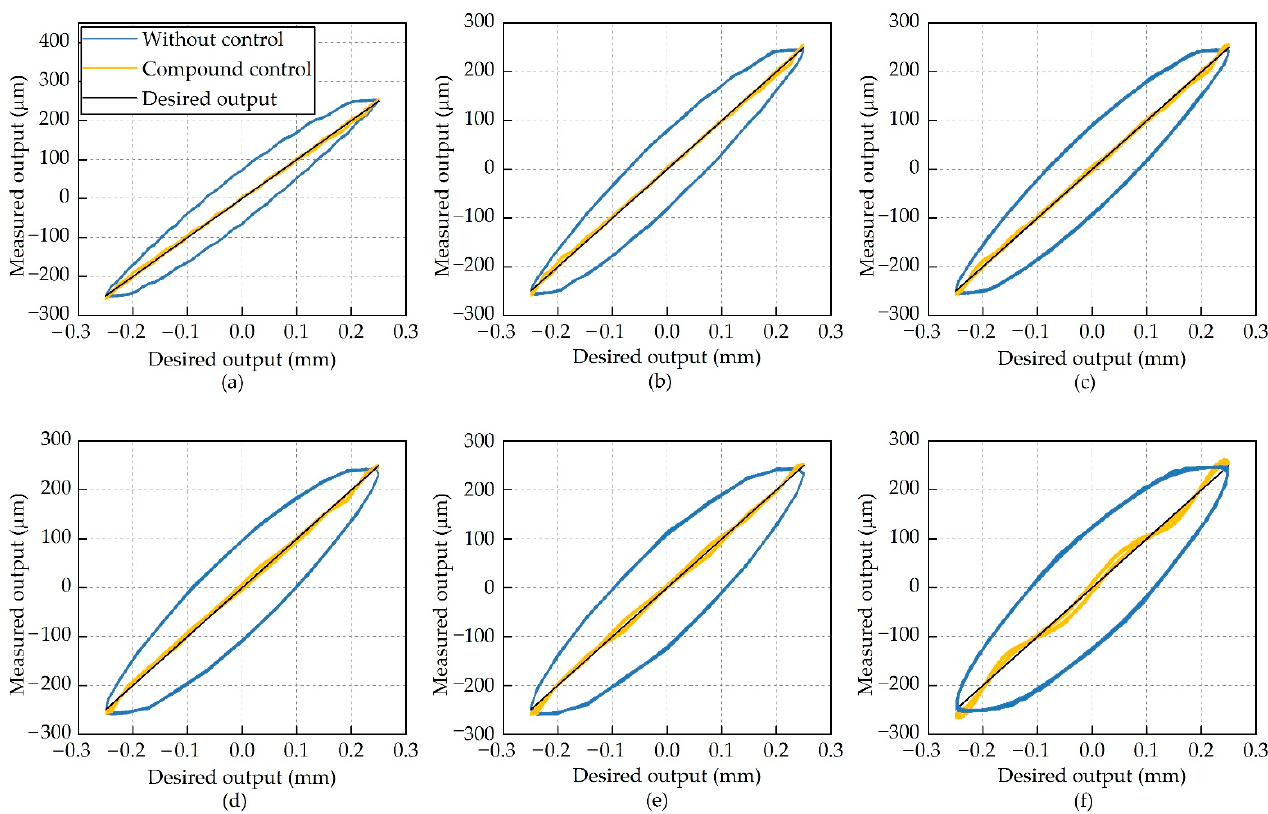
Figure 11. Actuator output strokes at different frequencies. ( a ) 10 Hz; ( b ) 20 Hz; ( c ) 30 Hz; ( d ) 40 Hz; ( e ) 50 Hz; and ( f ) 60 Hz.